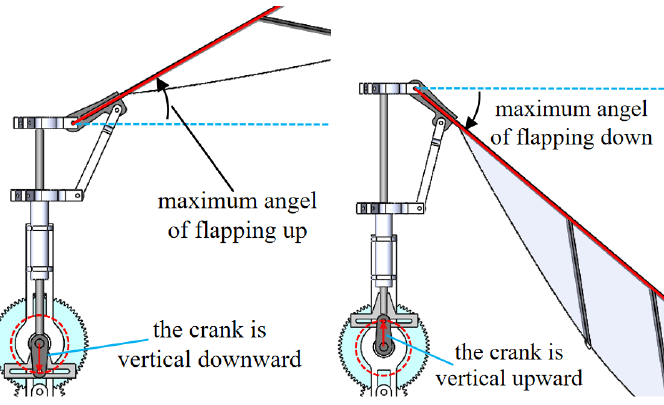
Figure 19. The maximum angle of flapping up and down. Table 4. The parameters of FWR with different maximum angles of flapping up and down.